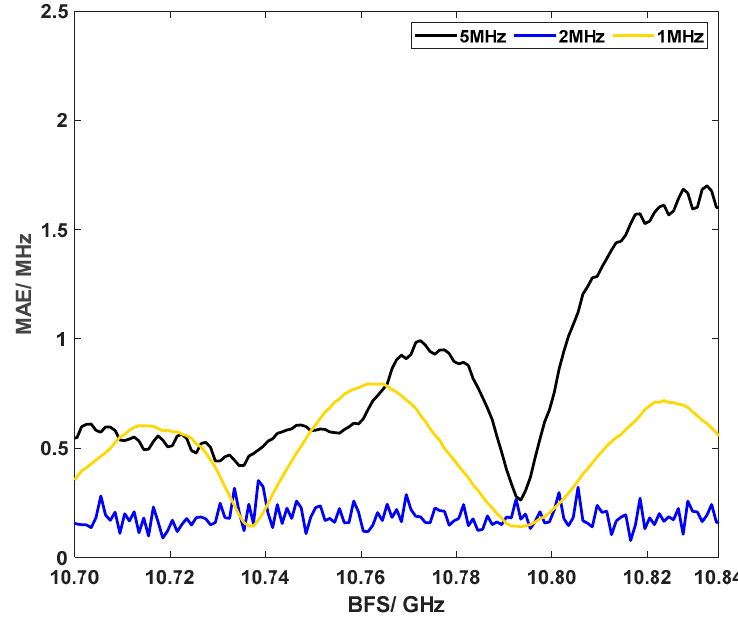
Figure 7. Adaptability of different steps for the FNN with PCA. Table 4. MAEs of different frequency scanning steps.